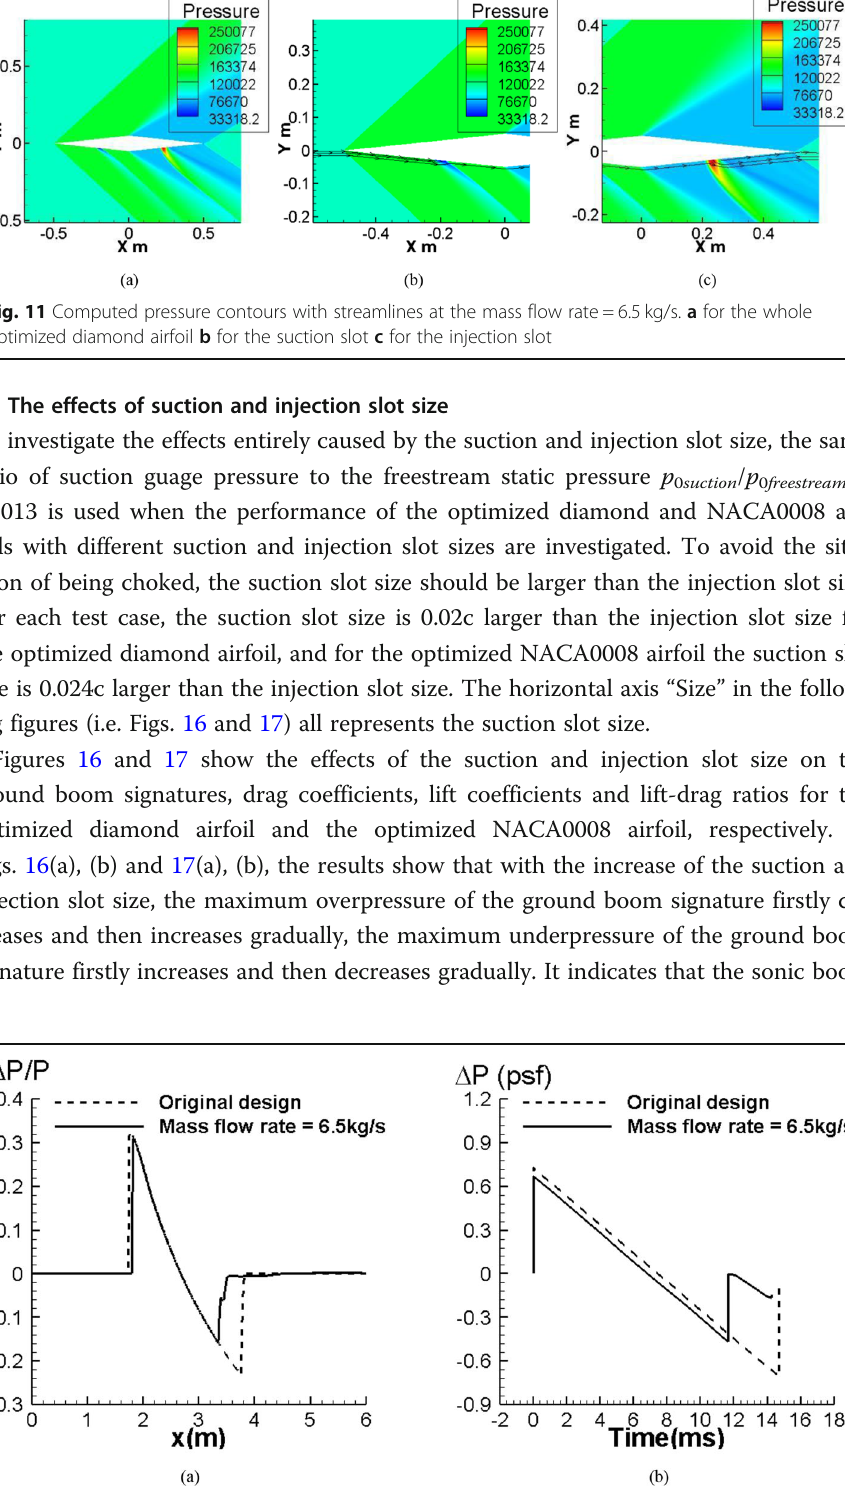
Fig. 12 The near-field singatures and corresponding ground signatures for the baseline and optimized diamond airfoil at the mass flow rate = 6.5 kg/s. a comparison of the near-filed signature b comparison of the ground boom